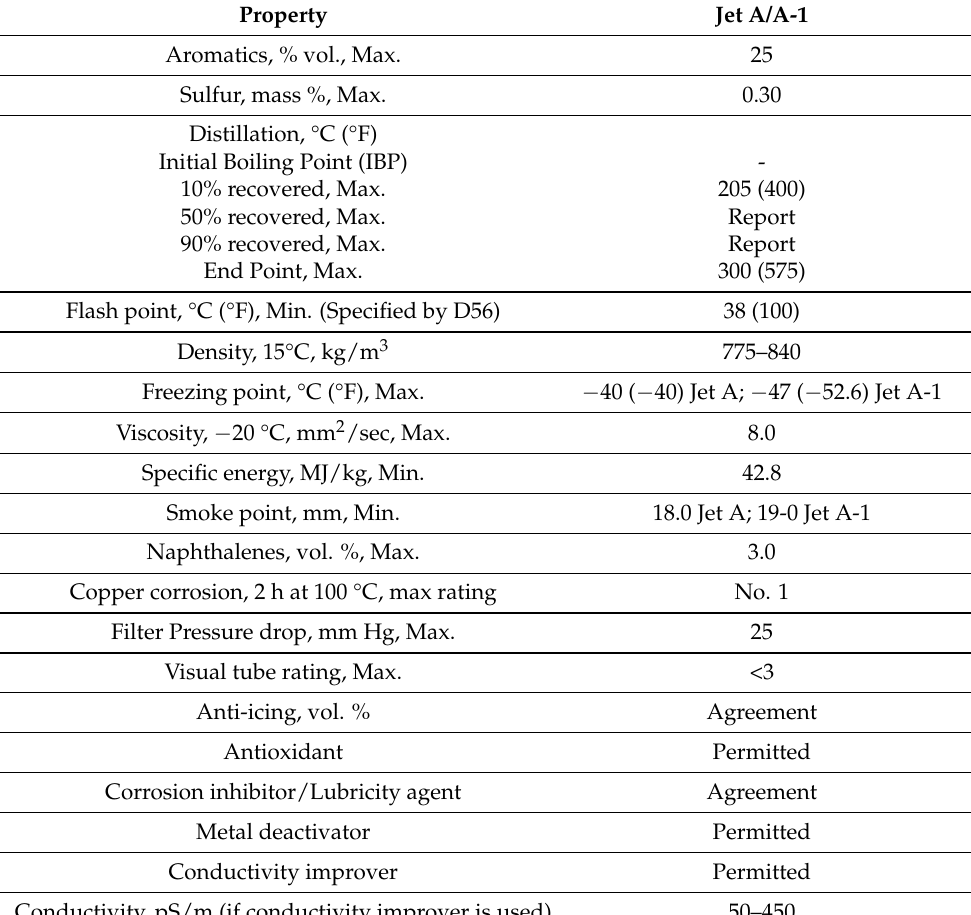
Table A1. Selection of ASTM D1655-specified jet fuel properties [35,117].